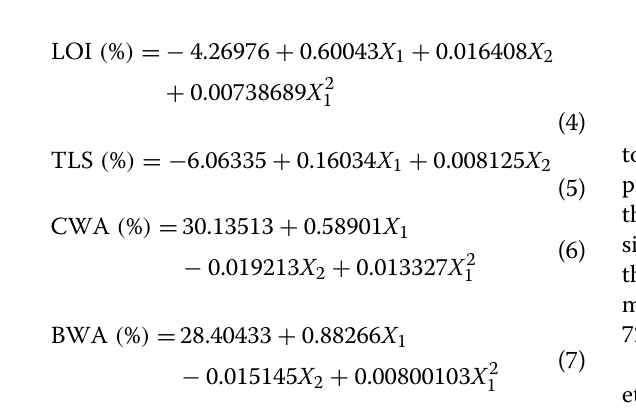
a Standard error of the mean b Standard error of the